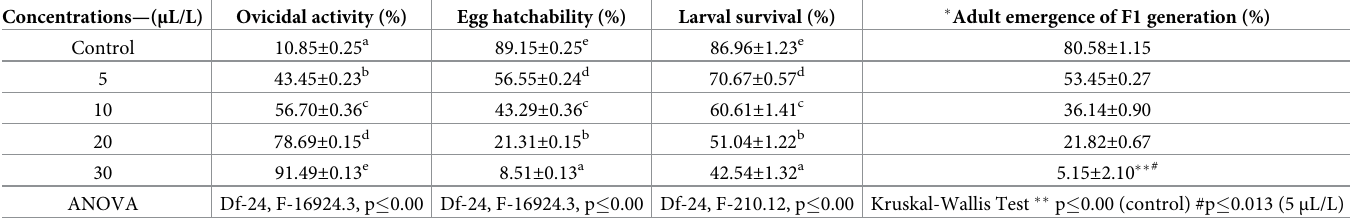
Mean of five replication ± SE; within the column same alpha b ê te do not significantly by Tukeys test (P �